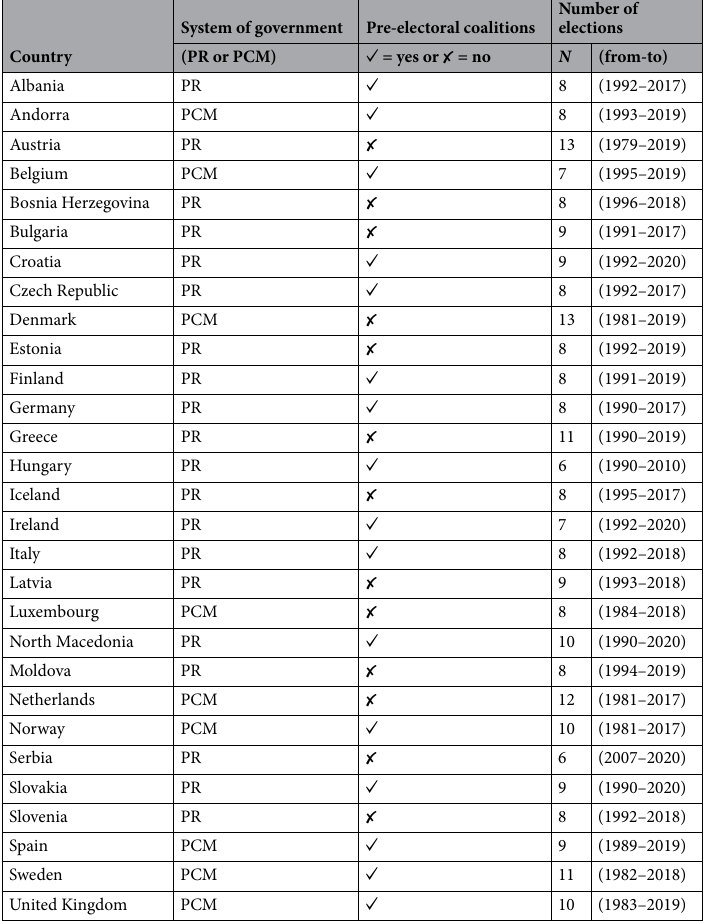
Table 1. List of countries considered in this study. For each country the following are shown: the system of government (PR: Parliamentary Republic, PCM: Parliamentary Constitutional Monarchy), the existence of pre-electoral coalitions, the number of general elections considered and their time